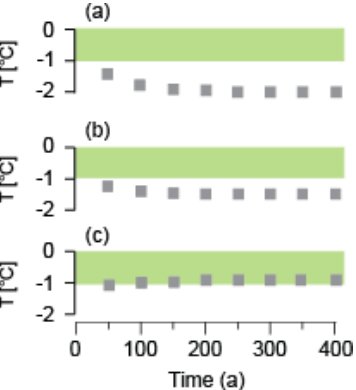
Figure 4. Thermal model runs simulating a change in YD climate starting at 12.24ka (mid-YD transition). Results show the ground temperature at 50m of depth (grey rectangles) at the depth of the CCC site in Cioccherloch. Model 3a (a) simulates the subsurface thermal conditions for a MAAT identical to scenario 2e (i.e. MAAT − 2 . 0 ◦ C), but the autumns and winters became drier, resulting in a reduction of the winter snow cover (snow (cid:49)T = 2 . 0 ◦ C). Scenarios 3b (b) and 3c (c) simulate the impact of a + 1 ◦ C rise in MAAT with respect to scenario 2c (i.e. MAAT − 1 . 5 ◦ C), and the 3c model also includes thin winter snow cover (snow (cid:49)T = 2 . 5 ◦ C). The green horizontal bar marks the − 1 to 0 ◦ C “window” of possible CCC formation at the depth of the CCC site in